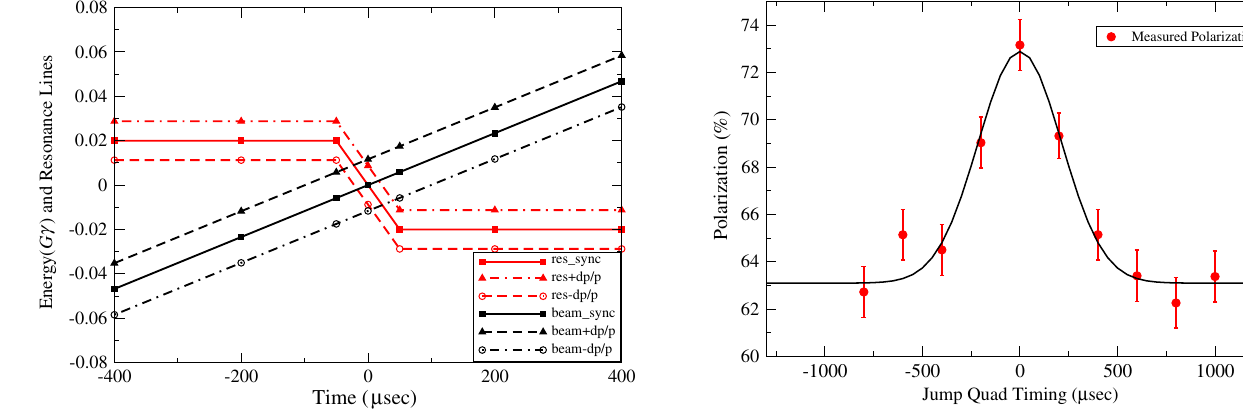
FIG. 11. The measured polarization at AGS extraction as FIG. 10. Sketch of the resonance crossing on the increase ν G γ ¼ 18 − ν ¼ 9 . 3 ). The function of overall jump quad timing. Error bars are statistical x side of the pulse at low energy( x errors only. The solid line is a fit of Gaussian distribution momentum FWHM width is assumed as 2 . 5 × 10 − 3 , which is with σ ¼ 214 μ close to the real dp=p here. In the lower energy case, the beam G γ spread is less important. Beam particles outside the FWHM benefit from the tune jump. The chromaticity of -7 is used for the plot.